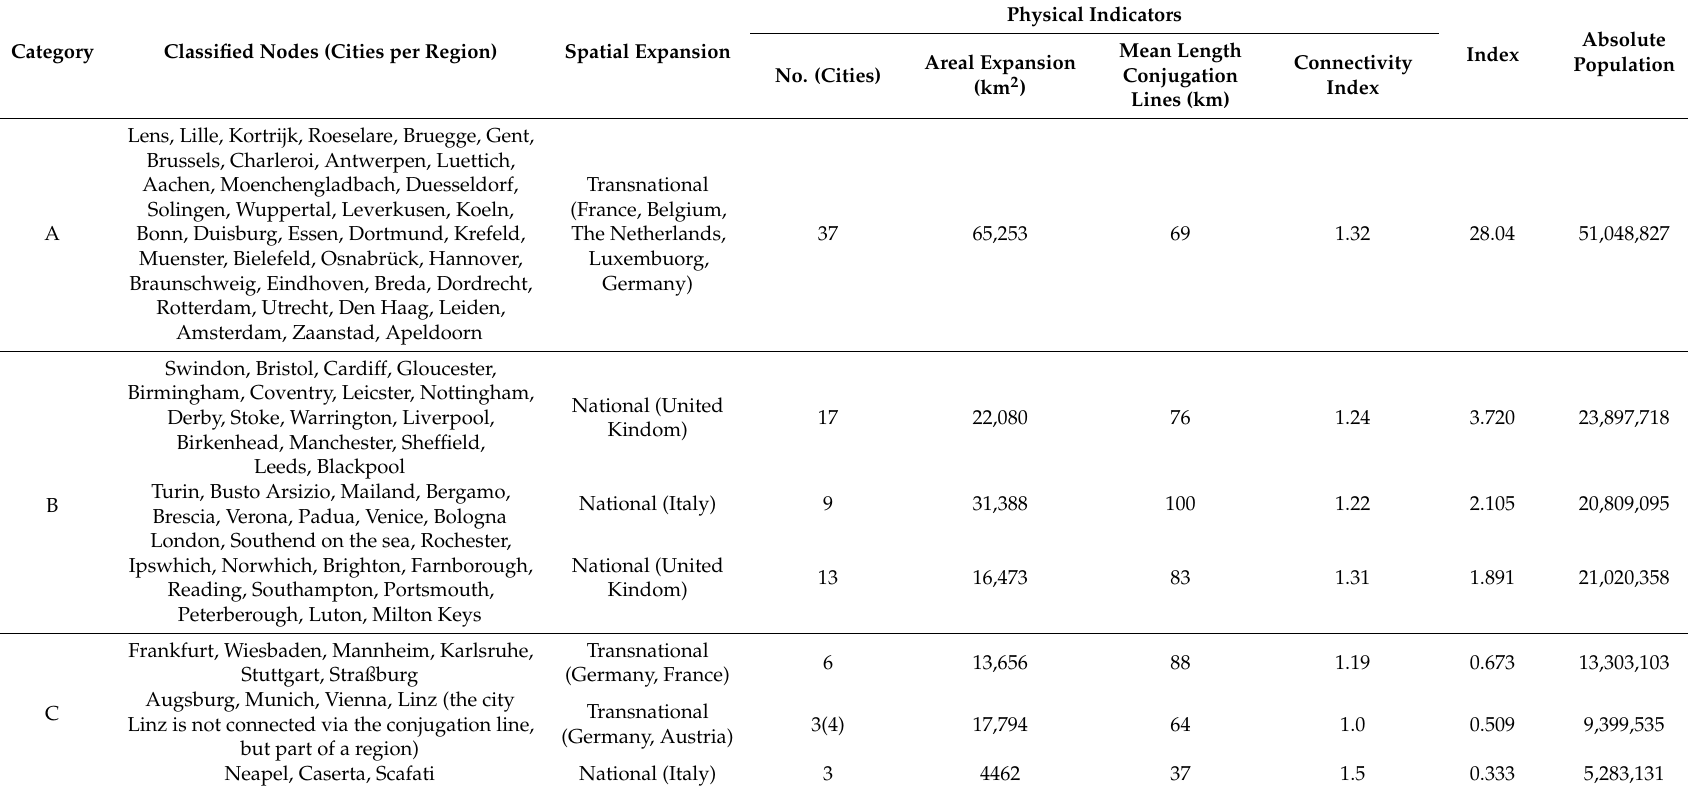
Table 1. Detailed quantitative characterization and categorization of the identified territorial regions and their respective nodes (Category A–D).